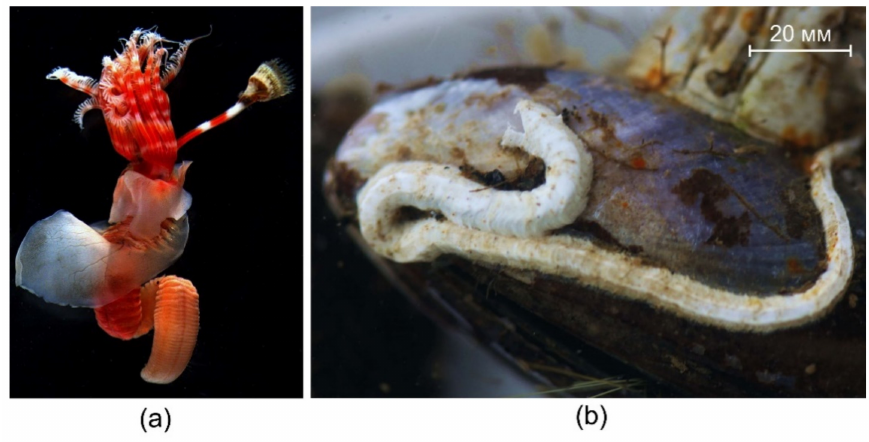
Figure 1. Hydroides ezoensis ( a ) without its tube, and ( b ) the tube. Scale bar 2